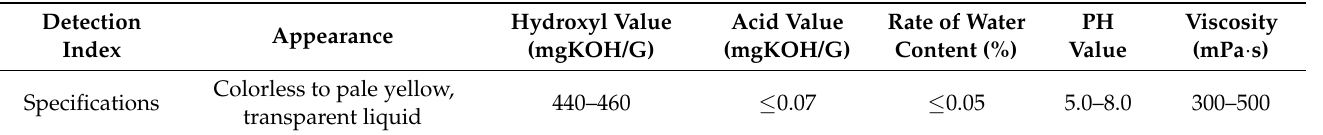
Table 2. Performance indexes of polyether